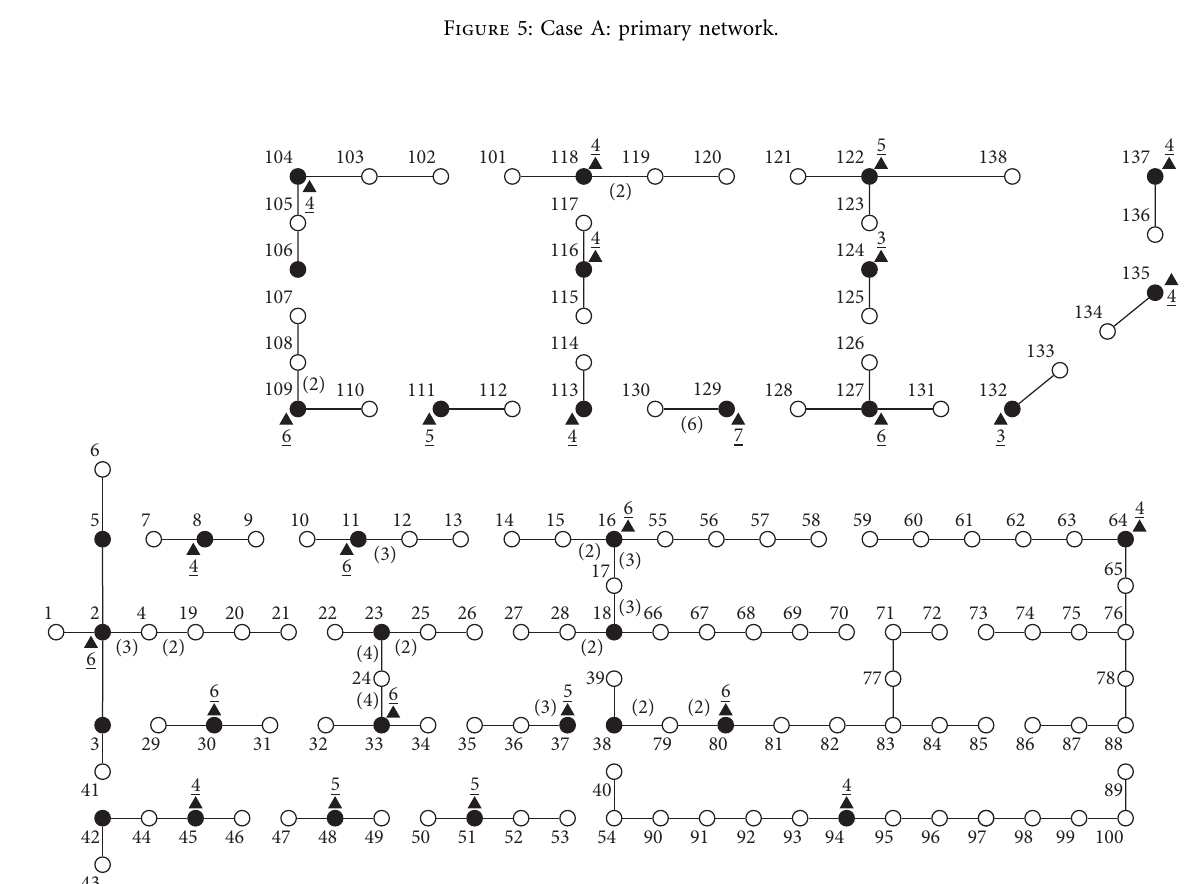
Figure 6: Case A: secondary